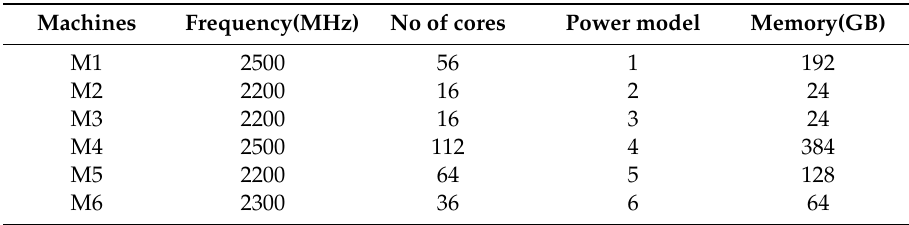
Table 2. Physical machine characteristics.